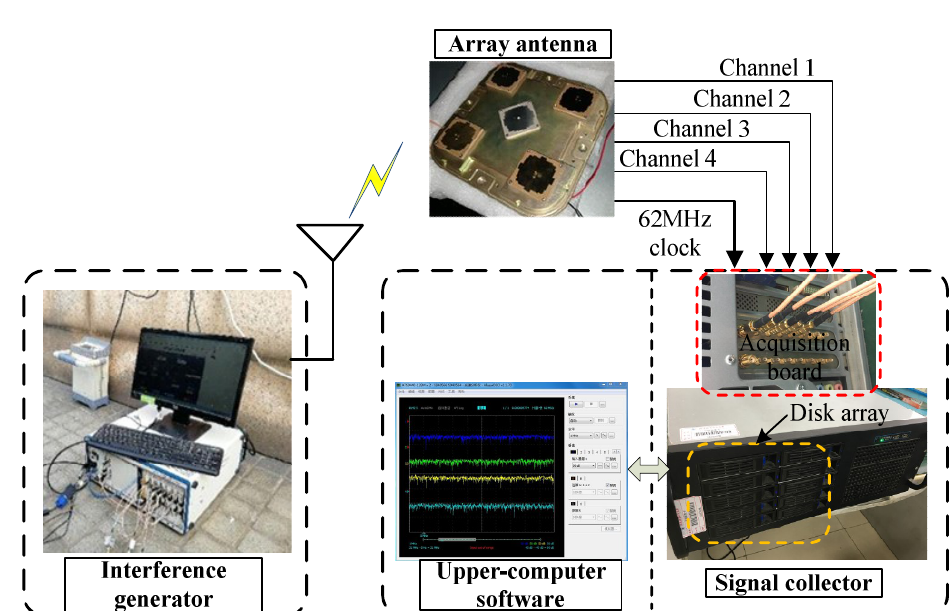
Table 3. Interference parameters. Parameter